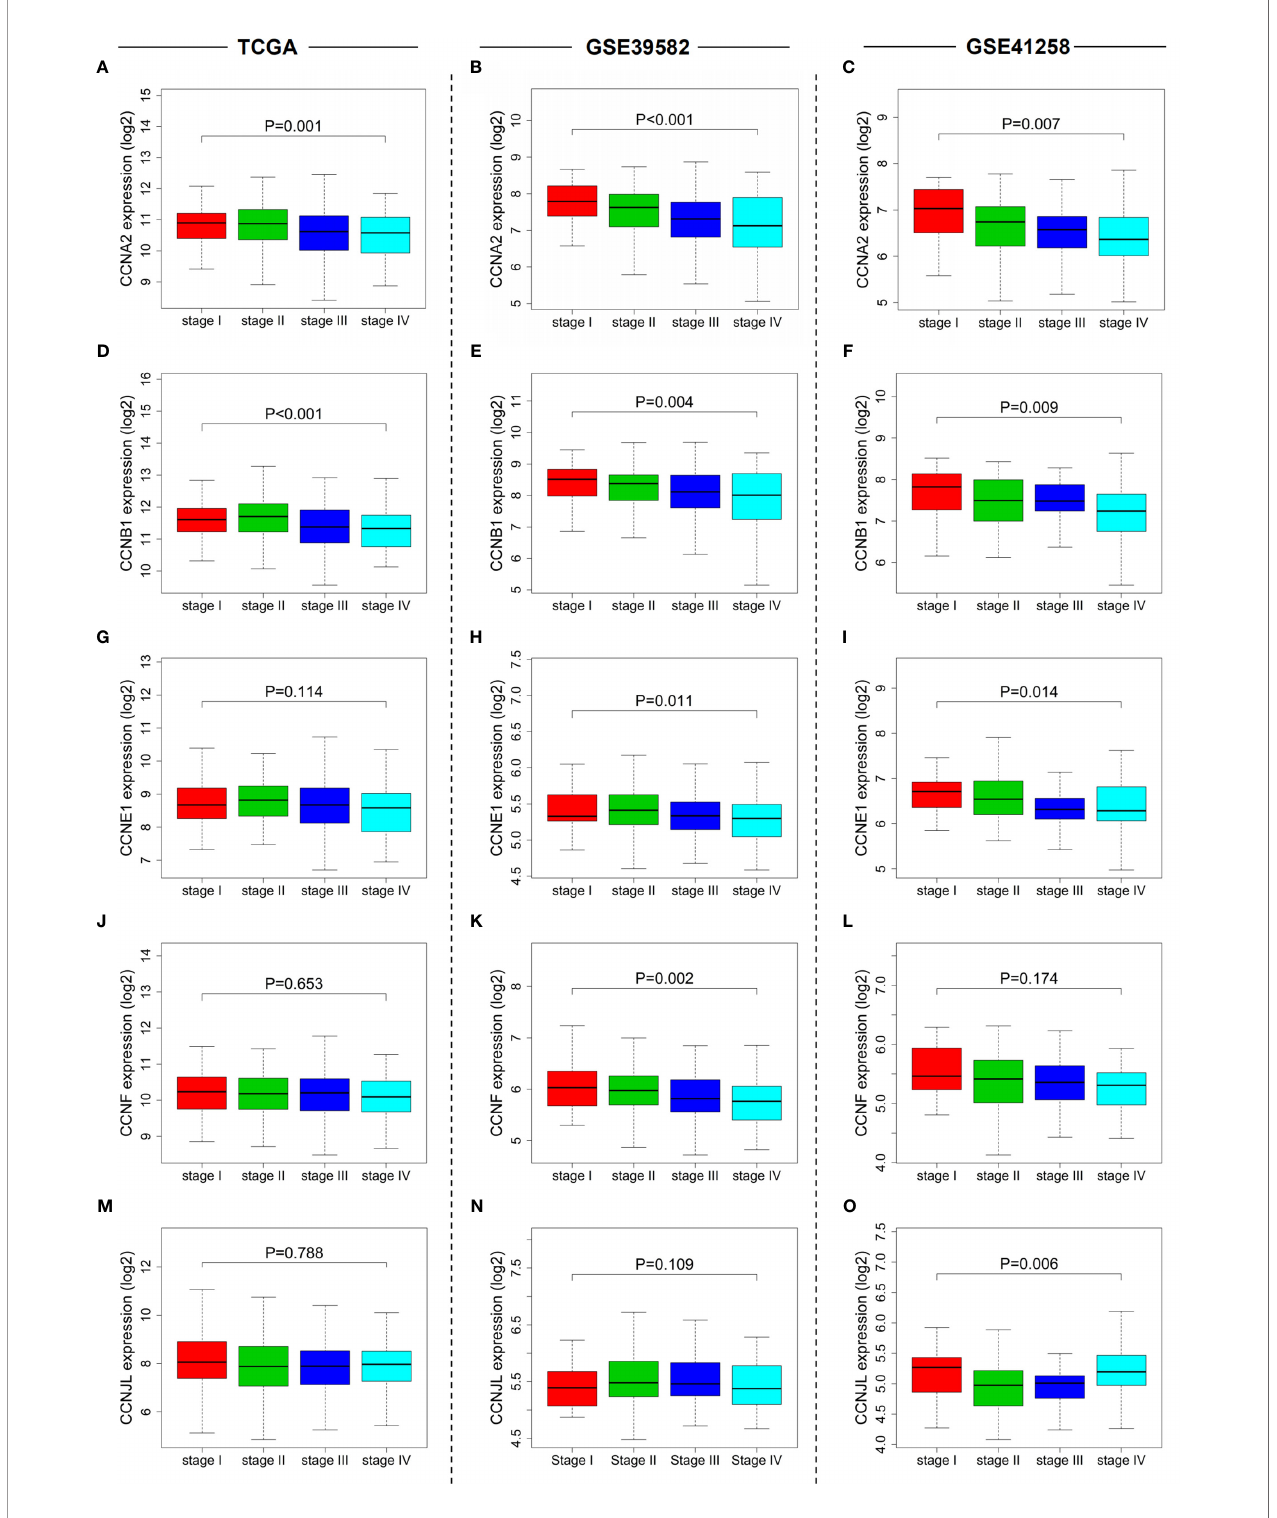
FIGURE 5 | Relationships between cyclin gene expression and patient TNM stages in the three datasets. The expression of CCNA2 (A – C) , CCNB1 (D – F) , CCNE1 (G – I) , CCNF (J – L) , and CCNJL (M – O) was signi fi cantly associated with patient TNM stages. For CCND1 , see Supplementary Figures 2A-C